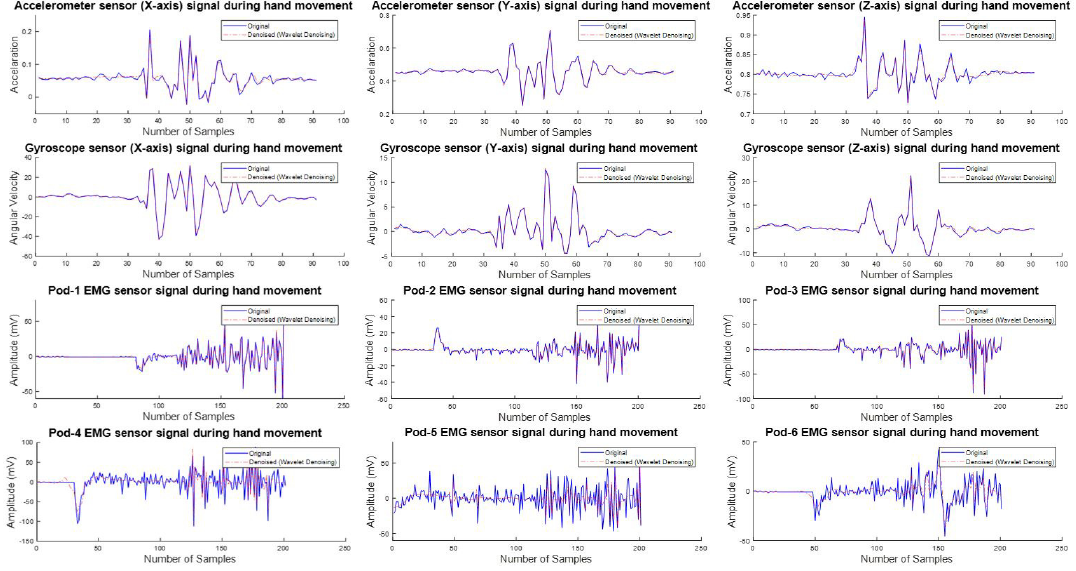
Figure 9. Example of the denoised signal of double-tap